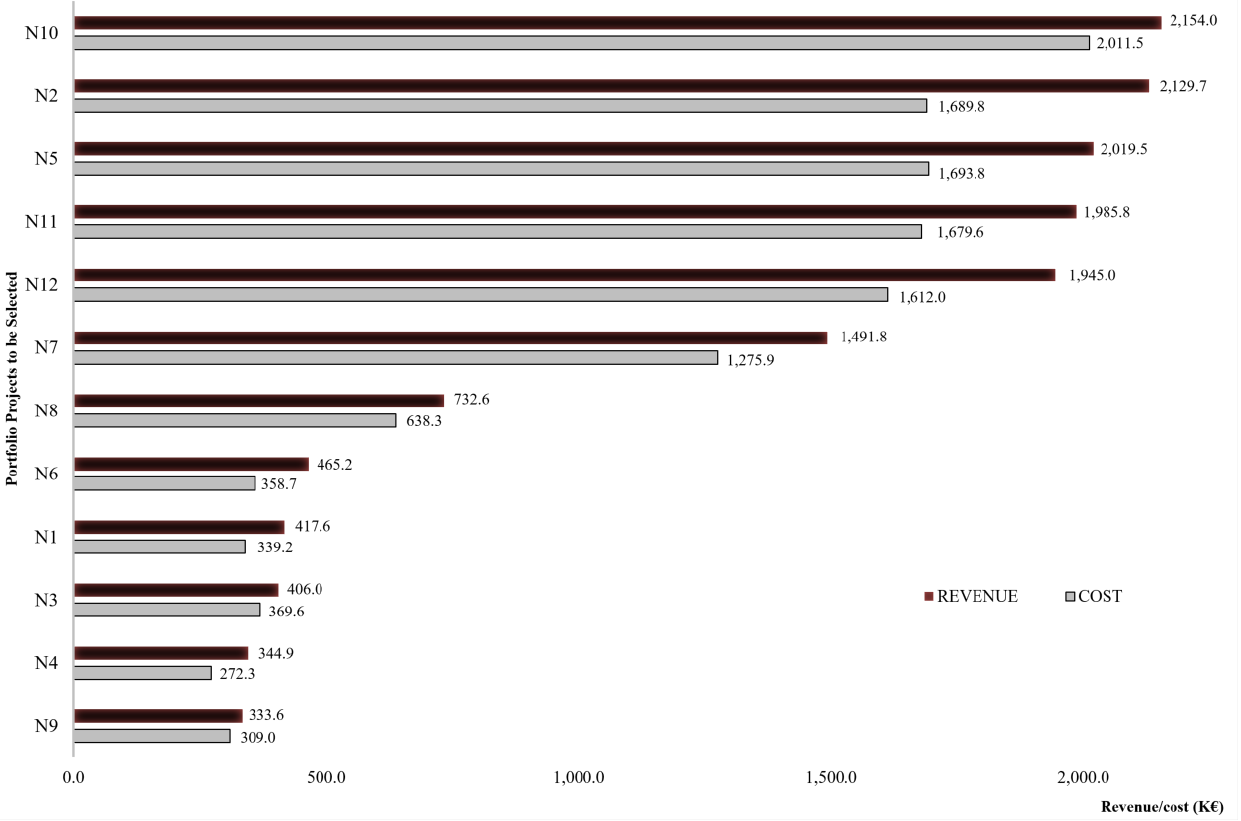
Figure 3. Revenue and cost of the new projects (Projects shown in descending order of Revenue).